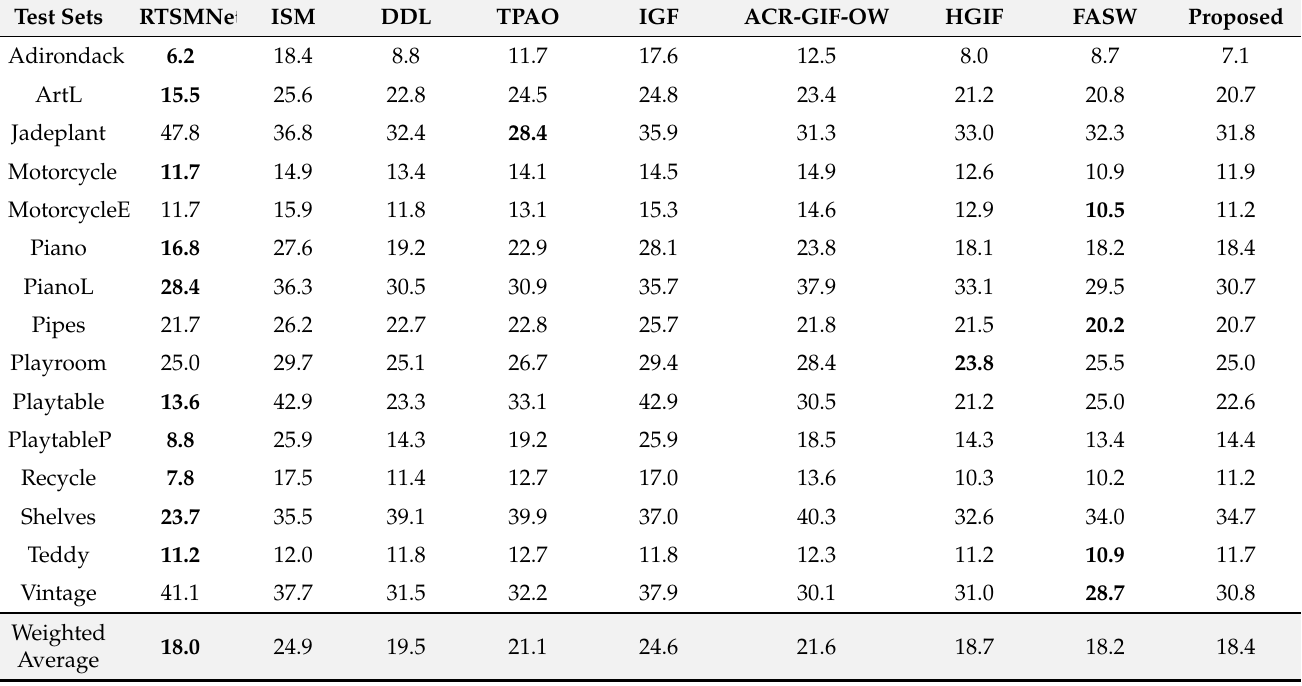
Table 3. Comparison of the error rates in the all-region without refinement (%). In calculating the error rates, the error threshold = 1.0. The best score for each image set is highlighted in